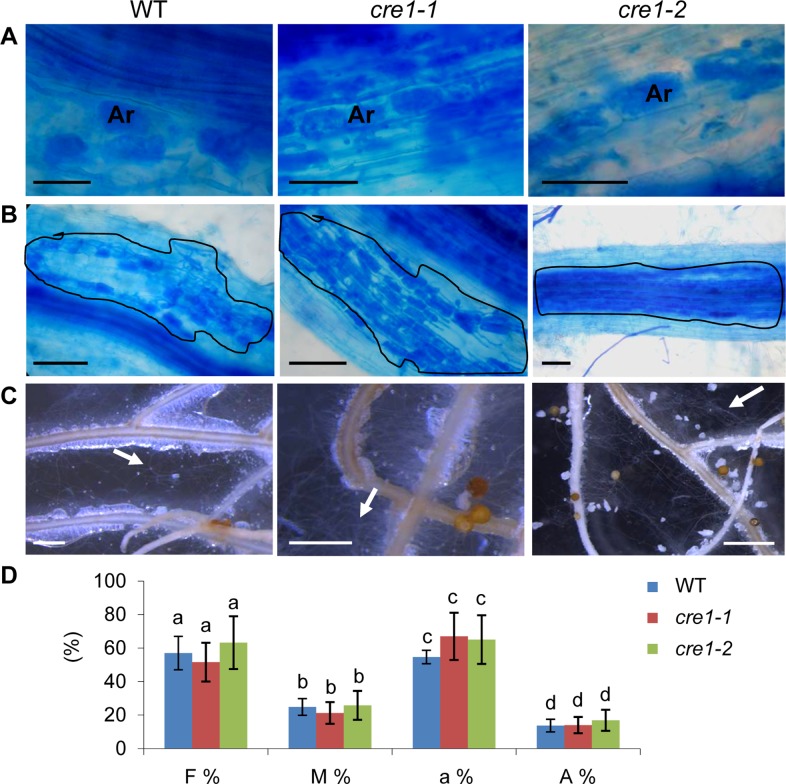
Mycorrhizal colonization of cre1 mutants is similar to wild-type.
A–C. Representative pictures of the Wild-Type (WT) and of the cre1 mutant phenotype (cre1-1 and cre1-2 alleles) after mycorrhizal inoculation: A, Arbuscule (Ar) development in root cortical cells; B, intraradical colonization (lines indicate the colonized regions); C, Extraradical mycelium development (arrows indicate external mycorrhizal hyphae). Bars correspond to 50 μm in A, 100 μm in B, and 2 cm in C. D. Quantification of the mycorrhizal colonization rate of the Wild-Type (WT) and of the cre1 mutant (cre1-1 and cre1-2 alleles) following criteria defined by [47]: F%, frequency of root mycorrhization; M%, intensity of mycorrhization in the root cortex; a%, percentage of arbuscules within infected areas; A%, percentage of arbuscules in the whole root system. Error bars represent standard deviations (n = 4 complete root apparatus analyzed), and a Kruskal-Wallis test was performed to assess significant differences, shown by letters (α<0.05).